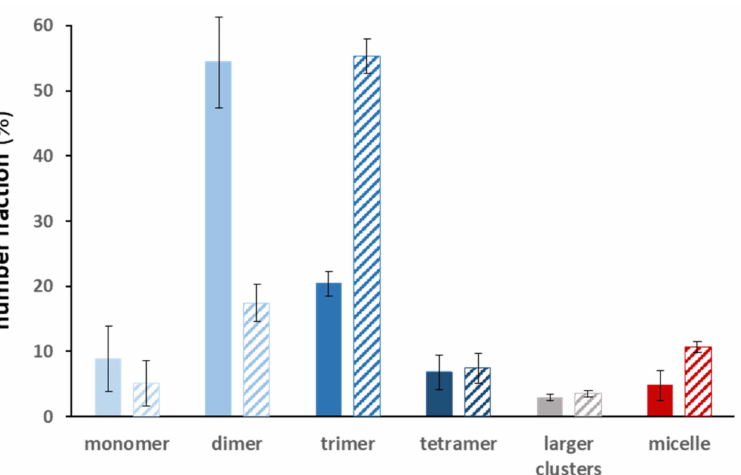
Figure 5. Number distributions of silica monomers, dimers, trimers, etc. as determined by the statistical analysis of the TEM images after 24 h of incubation of 115 nm one-patch silica particles (S = 0.87). The hatched histogram correspond to the same experiment including the addition of 50% more monomers after 8 h of incubation, with all else being equal: equivolume THF/ethanol mixture; silica particle concentration, 1.8 × 10 14 L − 1 ; temperature, 20 ◦